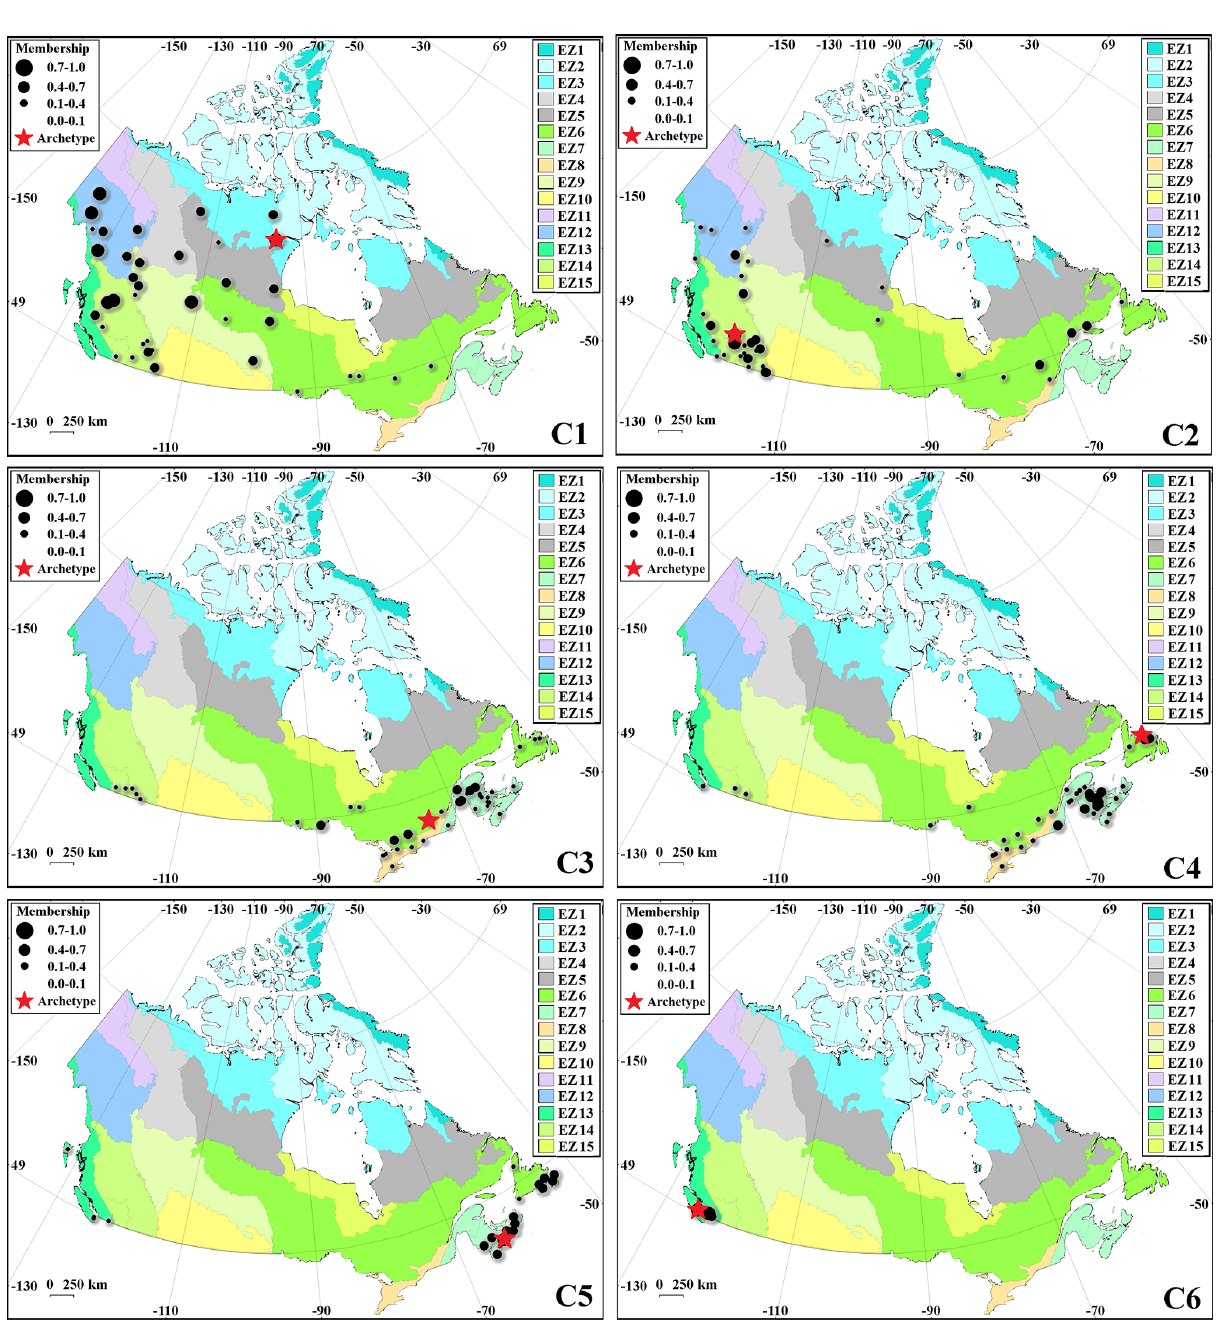
Figure 6. The distribution of the identified regime types across Canadian ecozones during the baseline l timeframe of 1966 to 1975. Each stream is represented by a circle with a radius proportional to a membership degree quantifying the association to a given regime type. Only RHBN stations with degrees of membership of 0.1 or larger are shown in each panel. The red stars are the archetype stations related to each regime